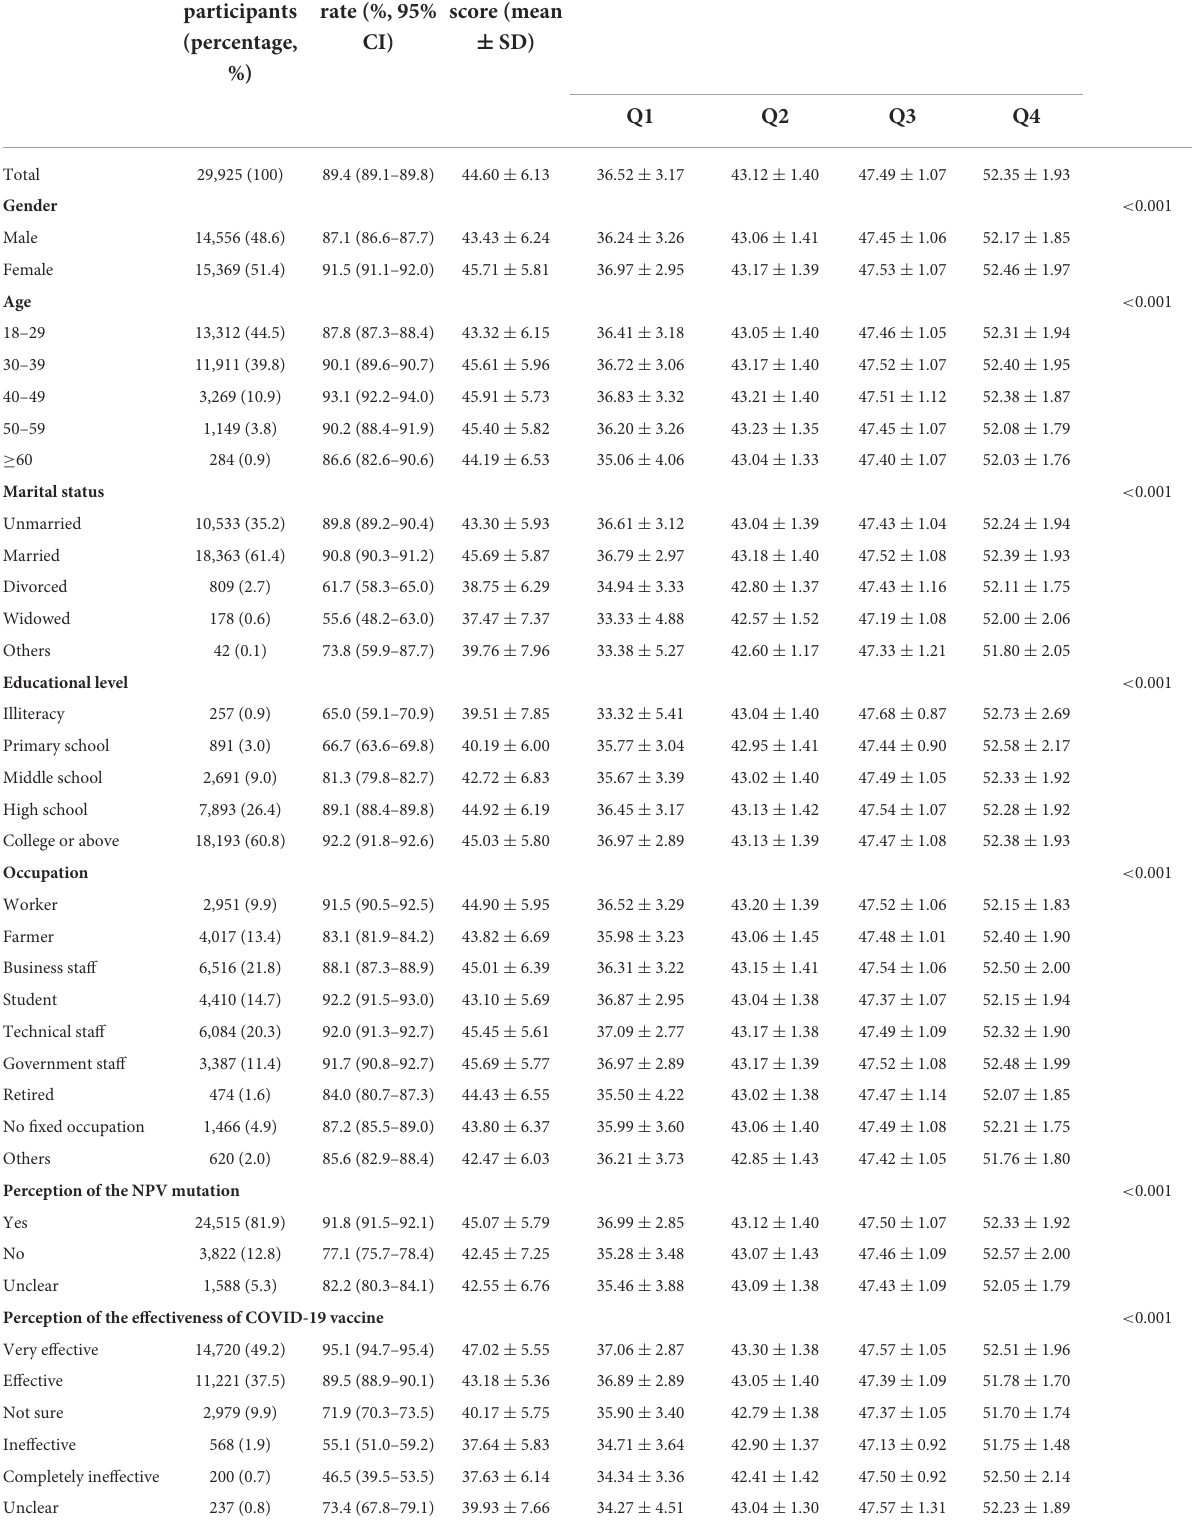
TABLE 1 Sociodemographic characteristics, COVID-19 vaccination rate, and the lifestyle score of all the study participants. Covariates Total